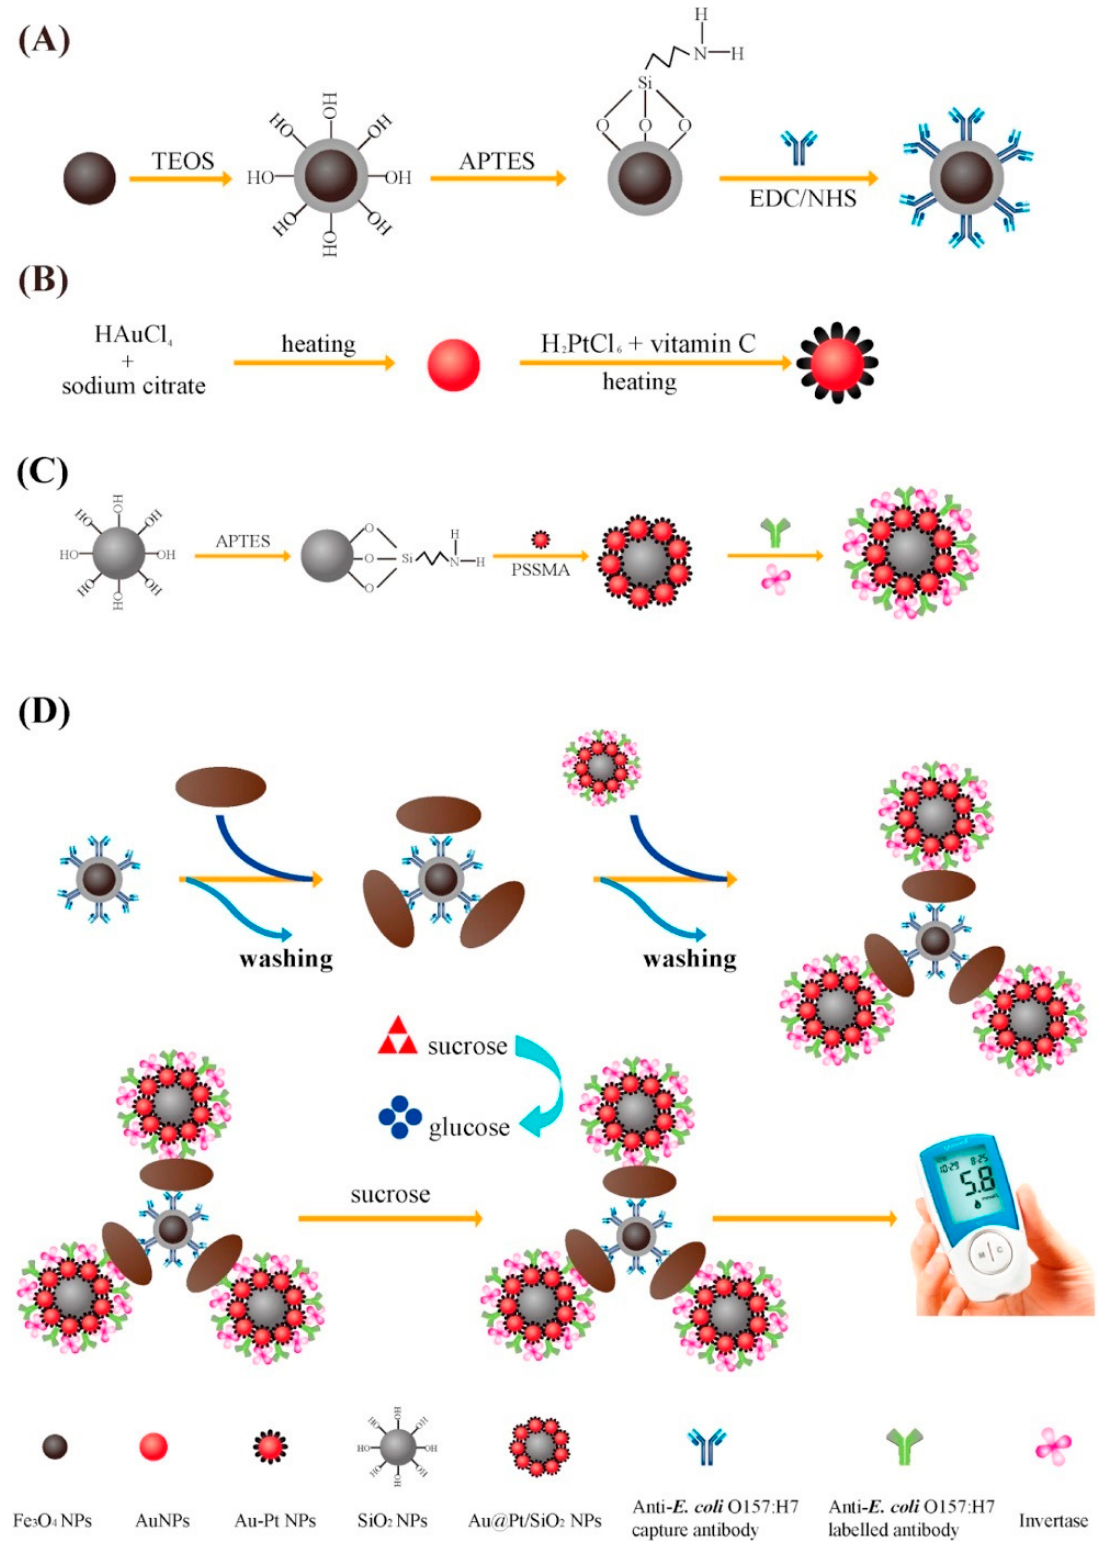
Figure 6. A schematic diagram of the preparation process of Ab-Fe 3 O 4 @SiO 2 NPs ( A ), Au@Pt NPs ( B ), Ab/invertase-Au@Pt/SiO 2 NPs ( C ); Experimental process of E. coli O157:H7 detection employing Ab-Fe 3 O 4 @SiO 2 NPs and Ab/invertase-Au@Pt/SiO 2 NPs based on PGM ( D ) [76] .